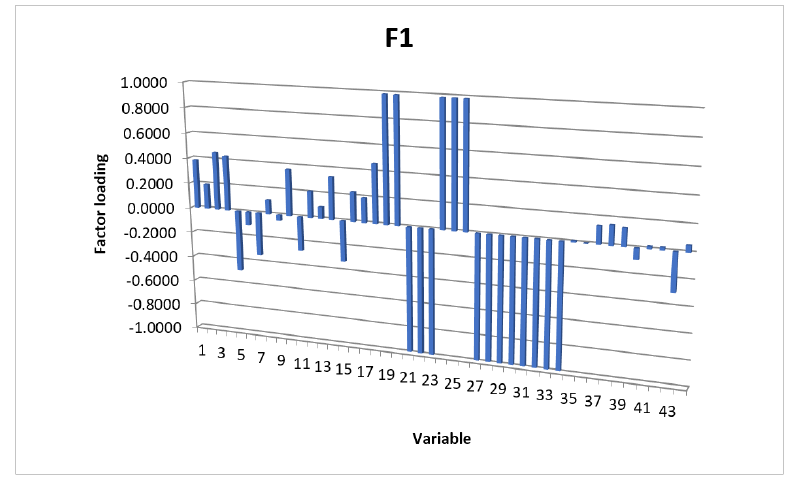
Figure 6. Graphic representation of factor loads values for input variables for factor F1.